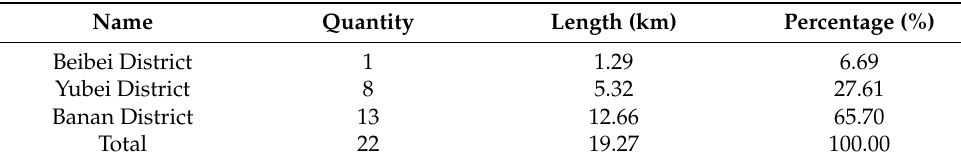
Table 10. Ecological “pinch point” length